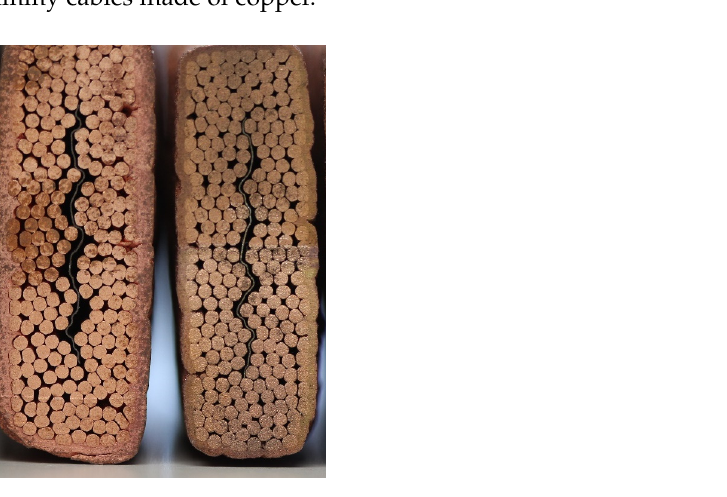
are performed in multiple